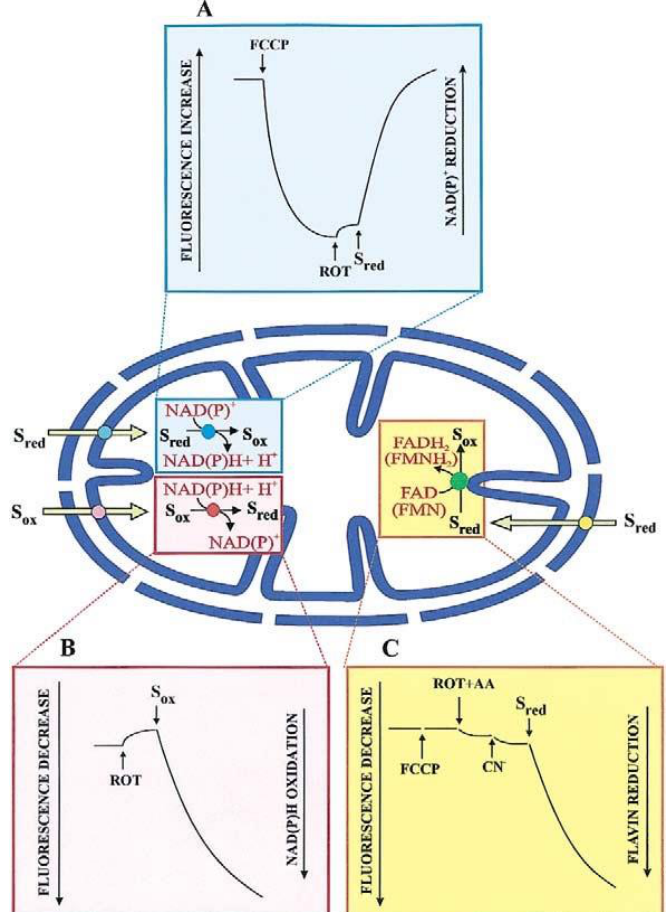
Figure 2. Intramitochondrial cofactor red/ox changes in transport studies. Depending on the context, fluorescence changes are studied as increase ( A ) or decrease ( B , C ). For details see the text. Abbreviations: AA, antimycin; CN, cyanide; FCCP, carbonyl cyanide p-trifluoromethoxy-phenylhydrazone (from Passarella et al. [9]). With permission from Elsevier, 2021.